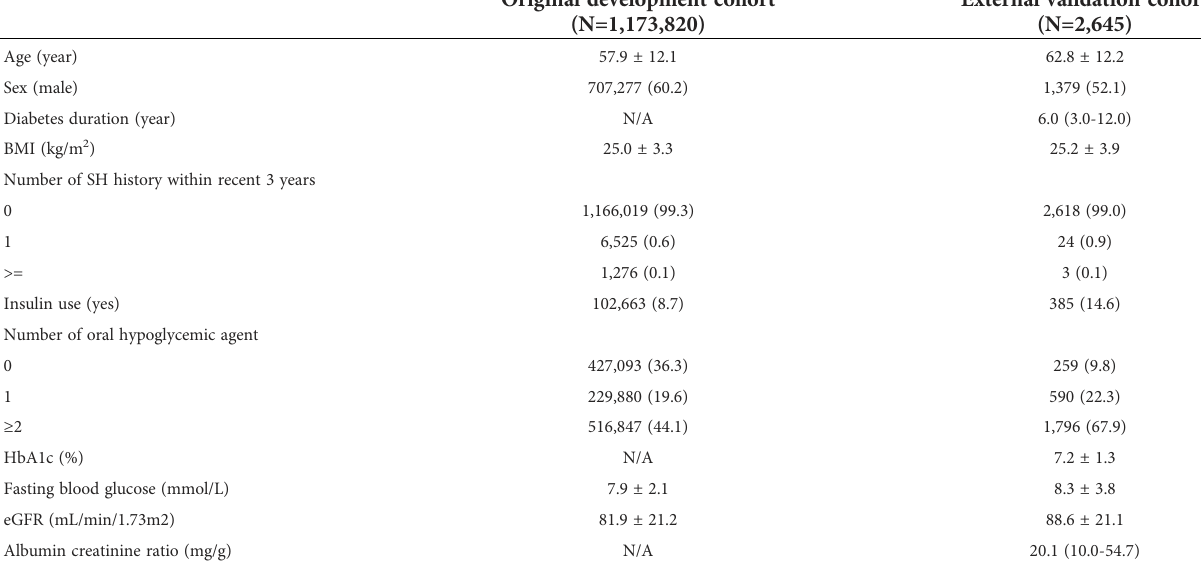
TABLE 1 Baseline characteristics of original and external validation